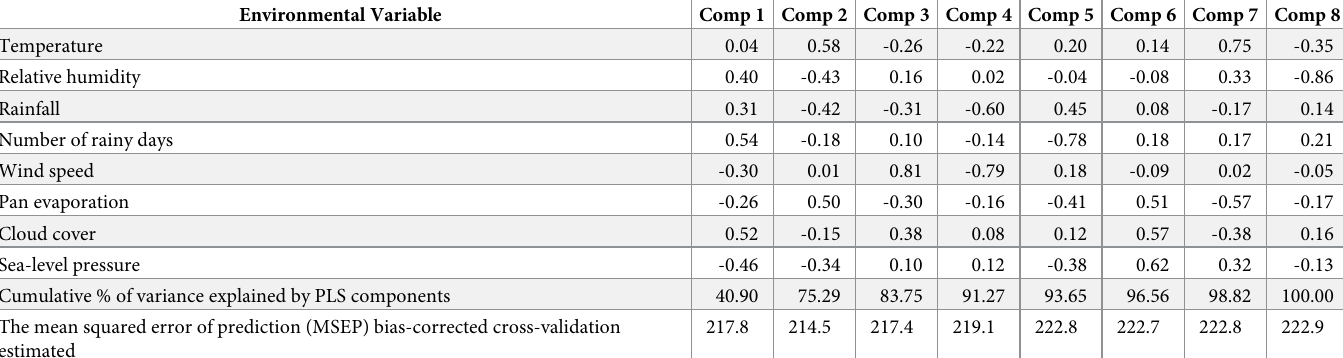
Table 2. Loadings corresponding to a PLS components performed on the incidence of dengue and the percentage variability explained by each component. Environmental Variable